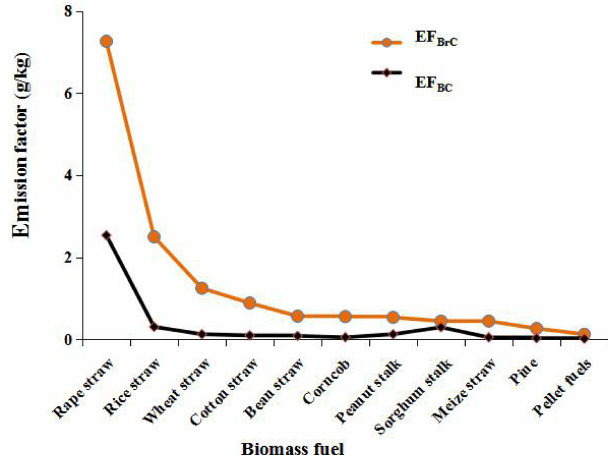
Figure 1. EFs of tested biomass